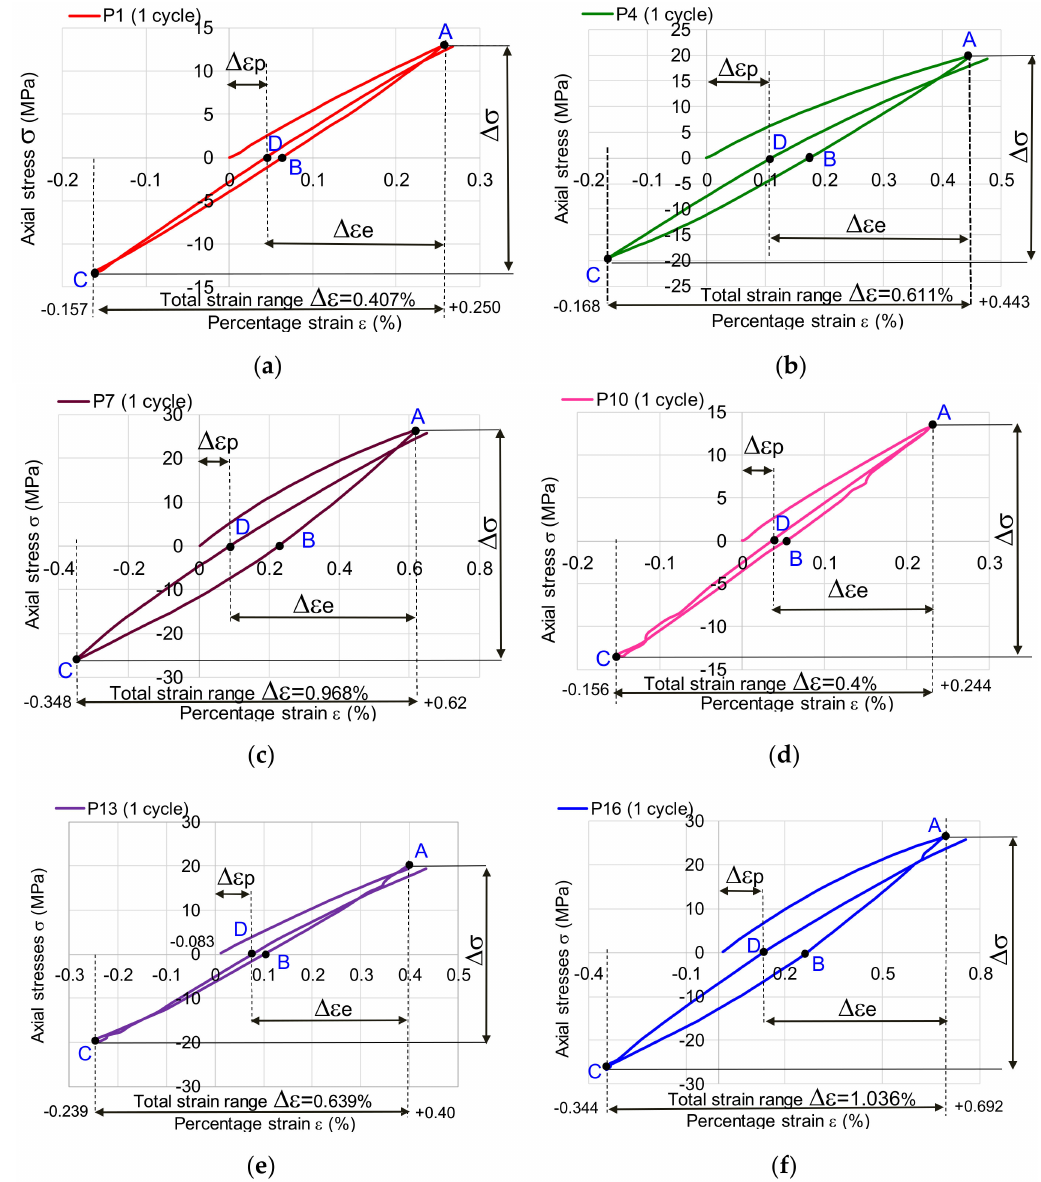
Figure 4. Hysteresis loops: ( a ) case of load speed of 1 mm / min and F = ± 1kN; ( b ) case of load speed of 10 mm / min and F = ± 1kN; ( c ) case of load speed of 1 mm / min and F = ± 1.5 kN; ( d ) case of load speed of 10 mm / min and F = ± 1.5 kN; ( e ) case of load speed of 1 mm / min and F = ± 2kN; ( f ) case of load speed of 10 mm / min and F = ± 2kN. Table 2. The strains values collected for first cycle, where ∆ ε is the total strain range; ∆ ε e —the true total elastic strain range; ∆ ε p —the true total plastic strain range; ε t –elongation strain; ε c —compression strain. Set of